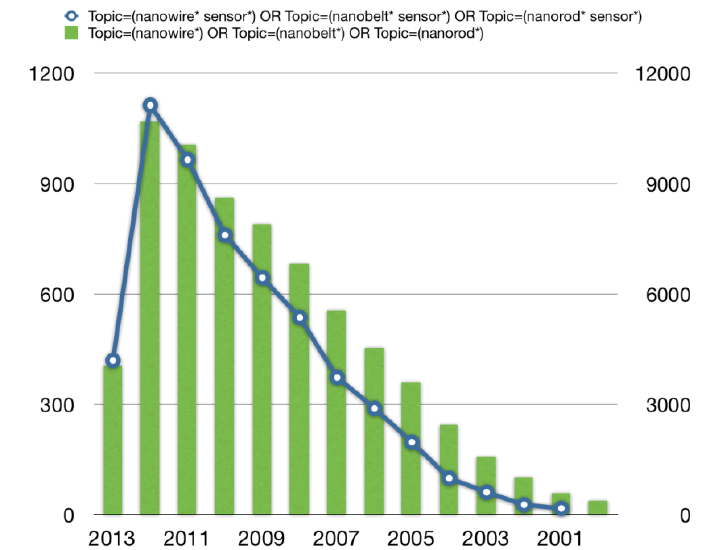
Figure 1. Number of publications as a function of the year from the isiwebofknowledge database 10/06/2013. Right axis: nanowires publications; left axis: nanowires sensors